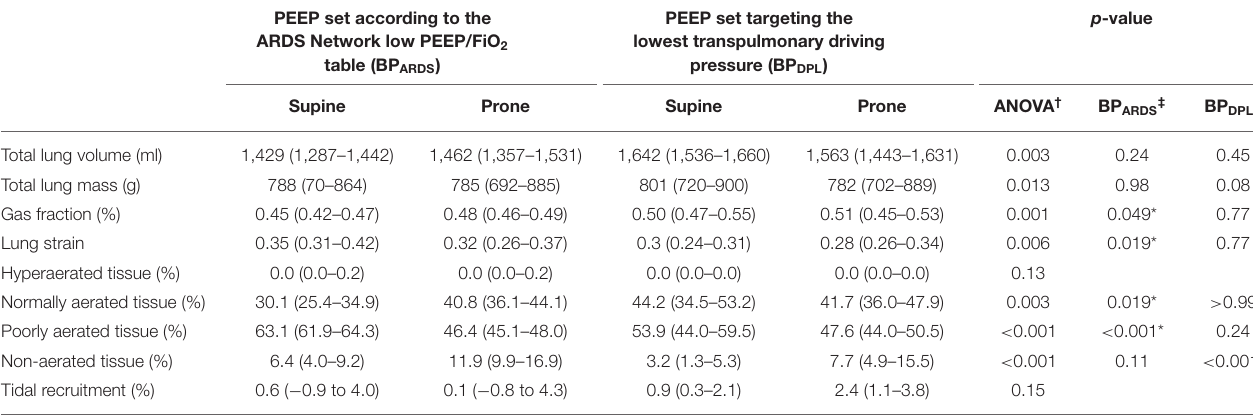
TABLE 2 | Computed tomography lung aeration data.